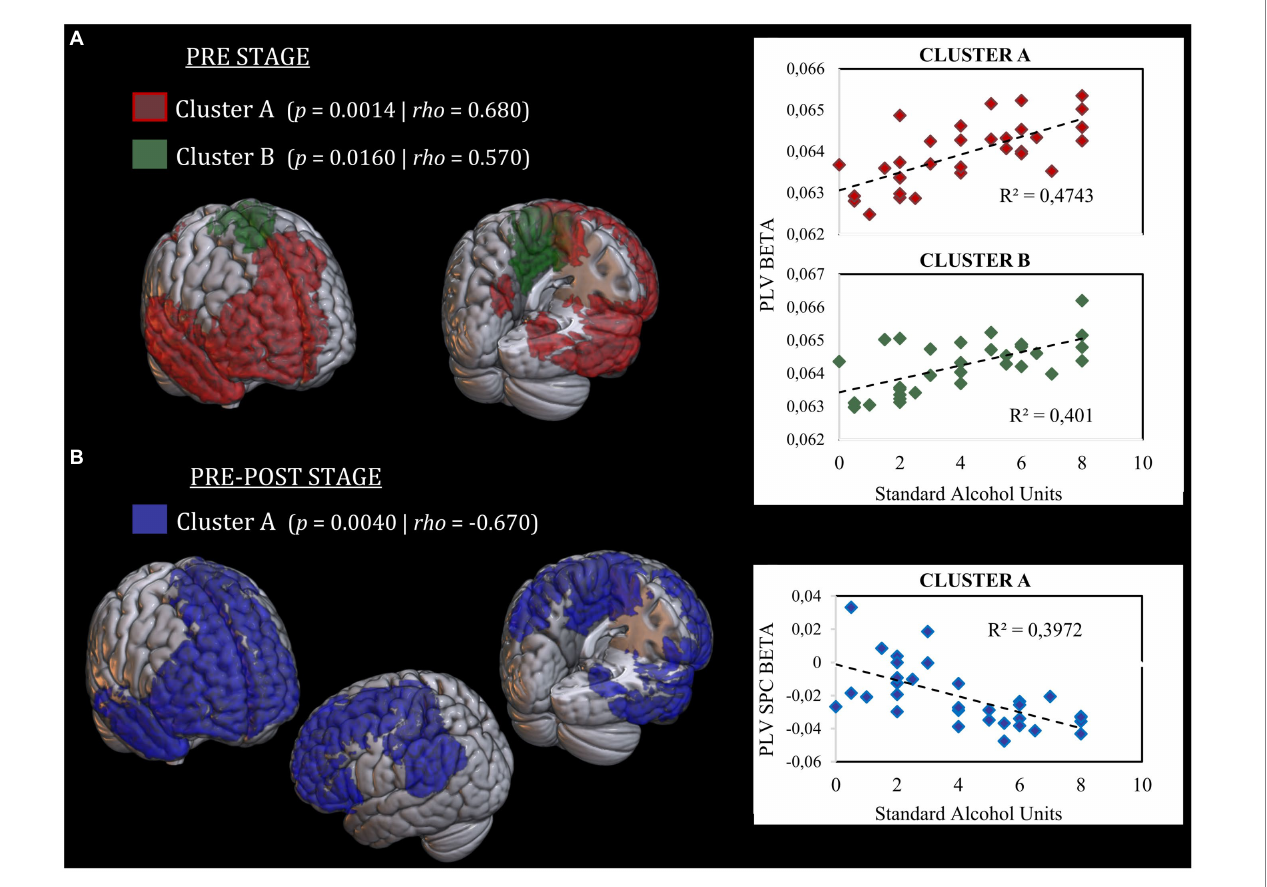
FIGURE 3 Representation of cortical distribution of significant clusters. (A) Significant clusters in the “ Stage-pre ” analysis. Cluster A is represented in red color. Cluster B is represented in green color. Both clusters show a positive correlation between FC and SAUs level. Scatter plots of correlation analysis are presented in the right side. (B) Significant clusters in the “ Stage pre-post ” analysis. Cluster A is represented in blue color. Cluster A show a negative correlation between SPC and SAUs level. Scatter plot of correlation analysis is presented in the right side. SAUs, Standard Alcohol Units; SPC, Symmetrized Percent of